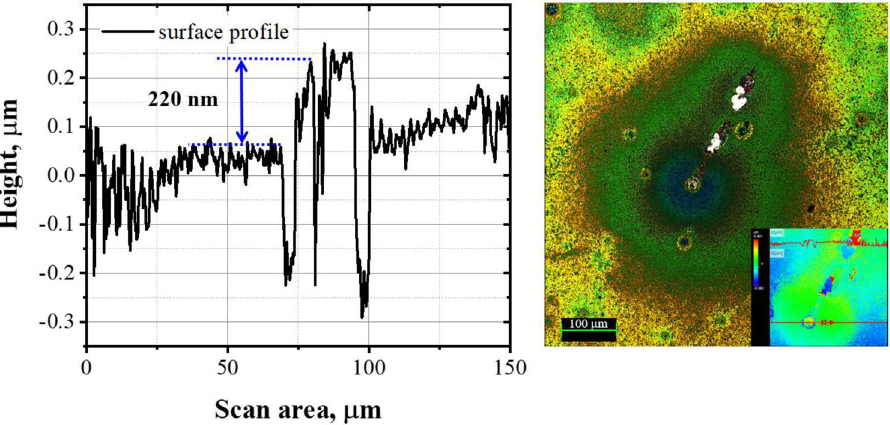
Figure 6. Residual thickness of Si/SiC/ta-C composite (Si–ta-C) coating (6.04 at.% Si) after annealing at 700 °C.